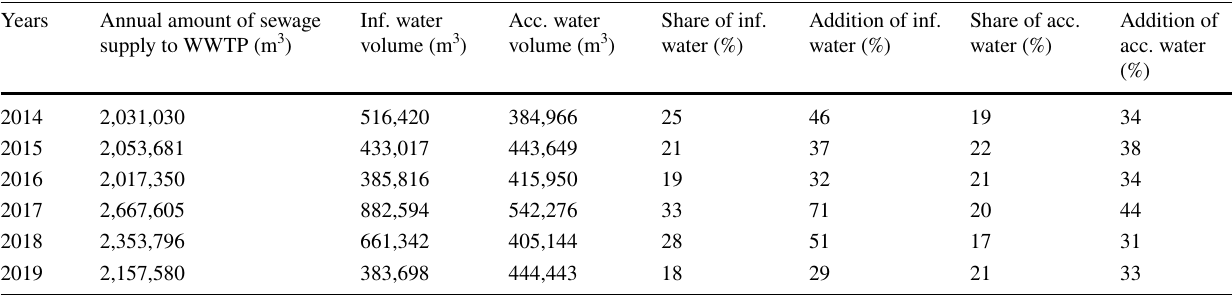
flow plotted on a daily inflow diagram in the year